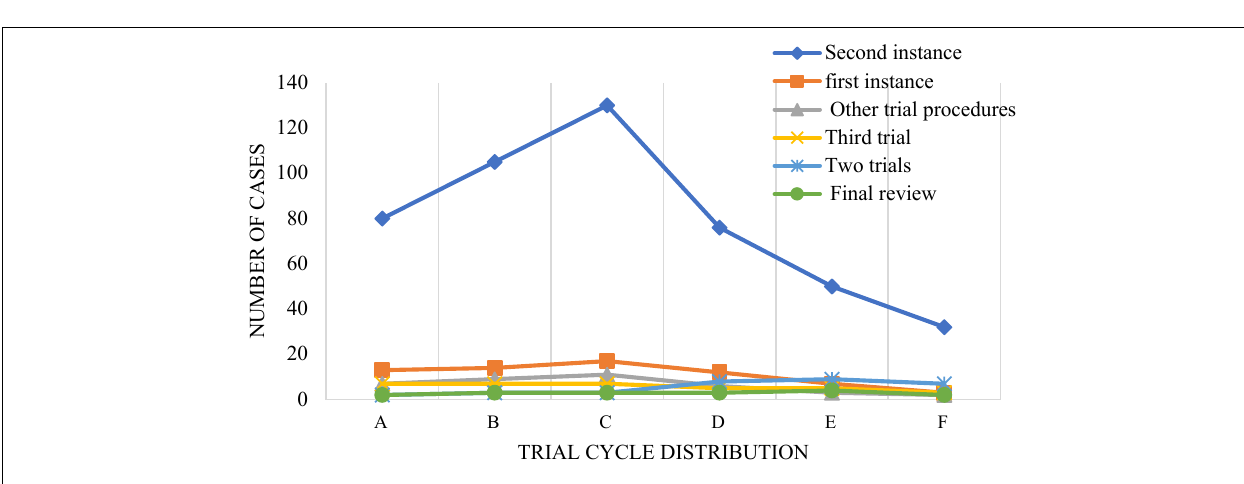
the number of open cases on the China Judgment Document Network from 2017 to 2019 (He,